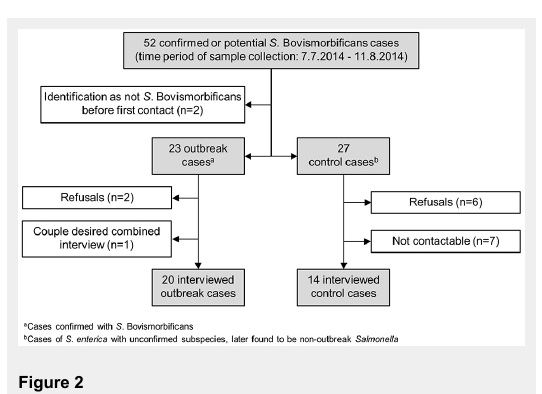
Pulsed-field gel electrophoresis (PFGE) profiles of selected Salmonella Bovismorbificans isolates from Germany (A) and Switzerland